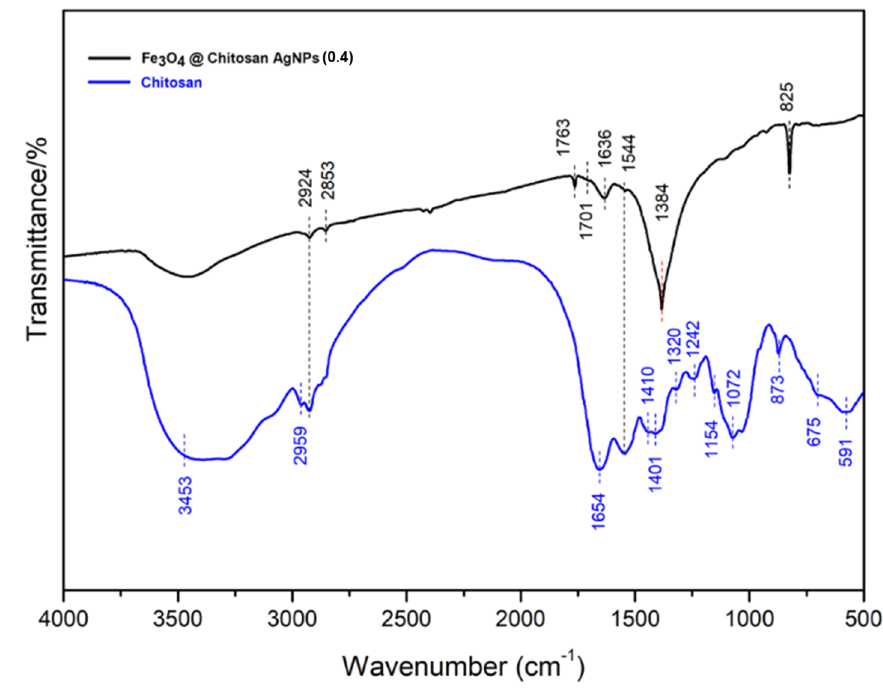
Figure 3. FTIR spectrum of Fe 3 O 4 @Chitosan-AgNP nanocomposites. Figure 3 . FTIR spectrum of Fe 3 O 4 @Chitosan-AgNP nanocomposites.